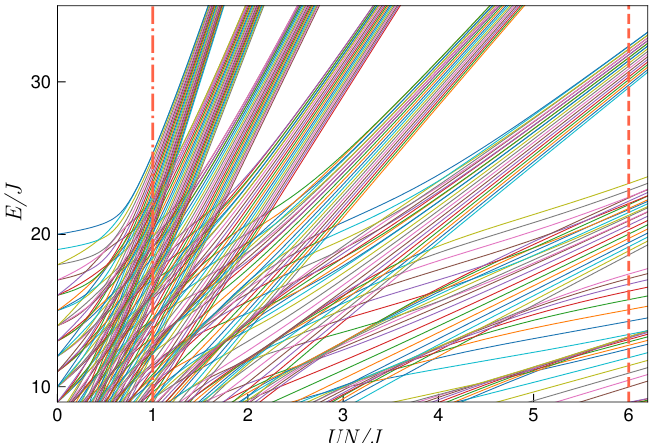
Figure 2: Energy level distribution. The dimensionless energies E / J are plotted against dimensionless coupling parameter UN / J . At UN / J = 0 the energies are equidistant and degenerate. As UN / J increases, the energies mix until reaching a nearly uniform distribution around UN / J (cid:39) 1 (the dot-dashed vertical line). Increas- ing UN / J further leads to the re-emergence of energy